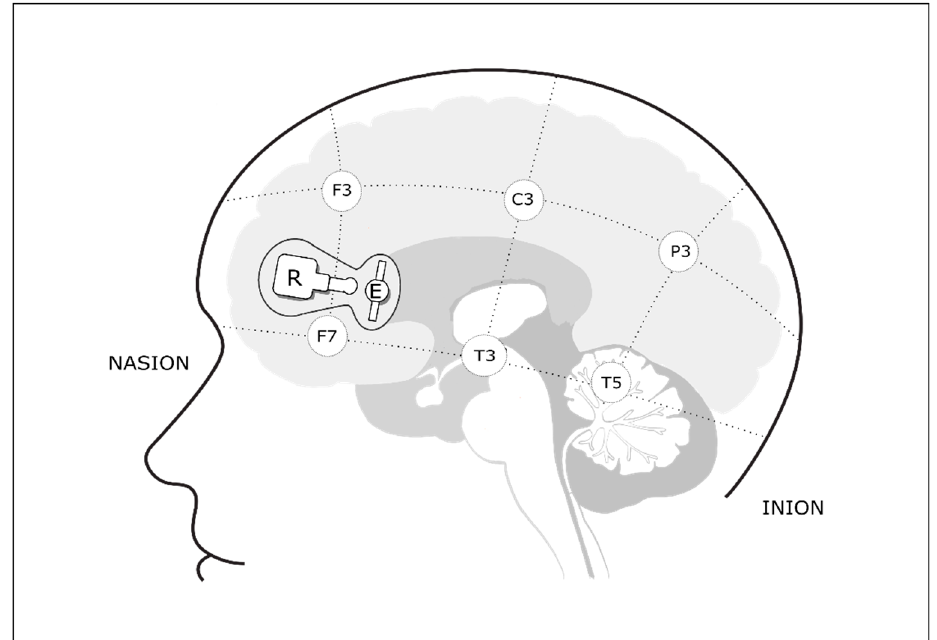
Figure 2. Lateral view representing optode position. Optodes were placed bilaterally with emitter (E) positioned anterior to T3/T4 and receiver (R) positioned anterior to F7/F8 according to the international 10–20 system.